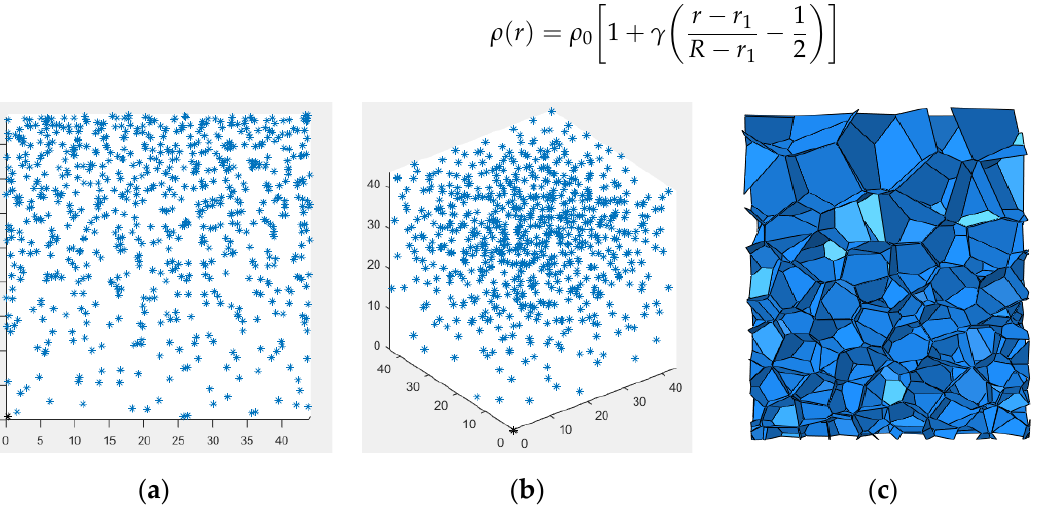
Figure 2. 3D-Voronoi modeling process. ( a ) Front view of nucleation point, ( b ) oblique view of nucleation point, and ( c ) foam model.